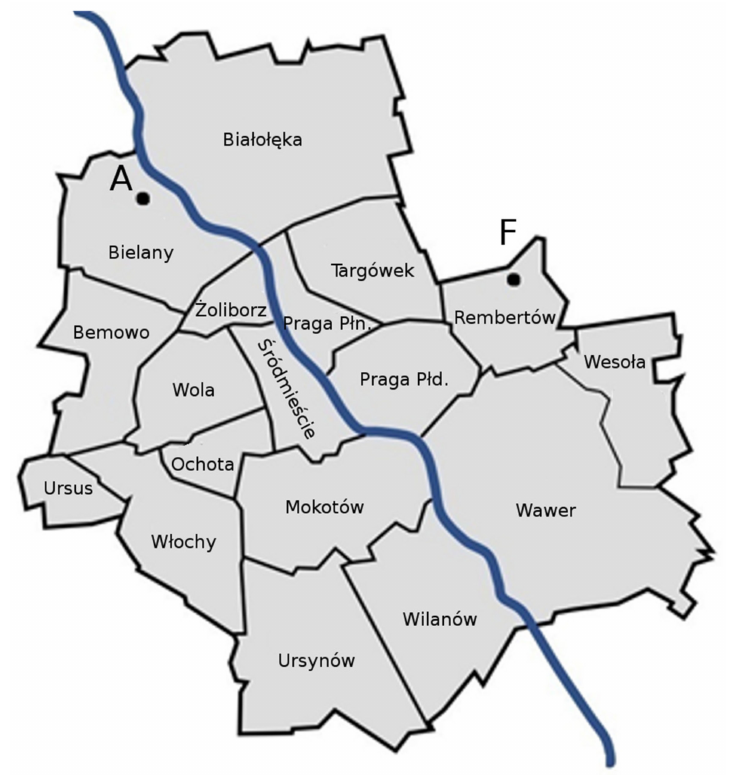
Figure 2. Measurement locations on a map of